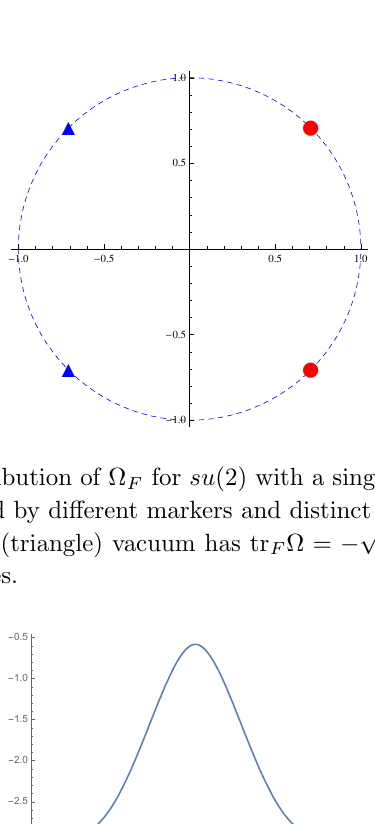
= 2 and n G = 2. We (200)